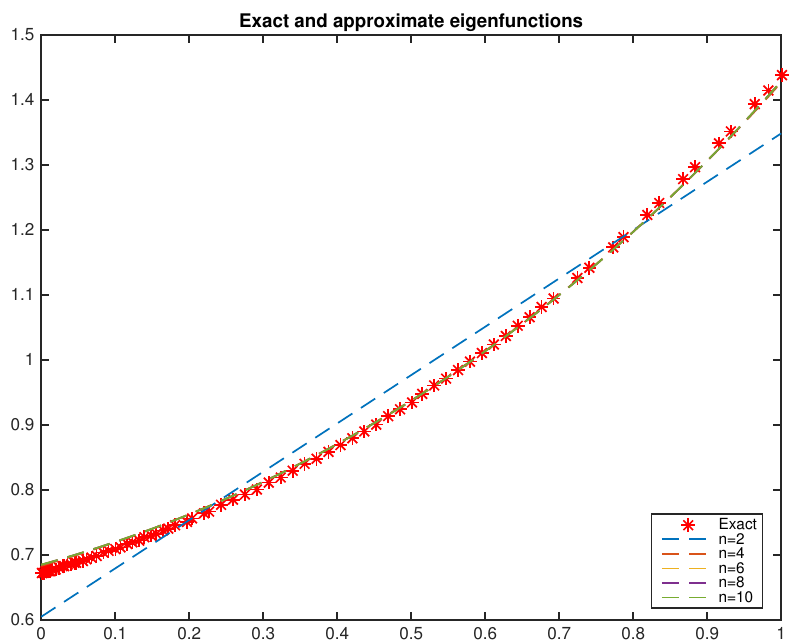
Figure 1. Exact and approximate eigenfunctions for the kernel K ( x , ξ ) = exp ( 2 x ) + exp ( 2 ξ ) over [ 0,1 ] 2 at various truncation orders.